Question: In a single sentence, describe what this figure presents.
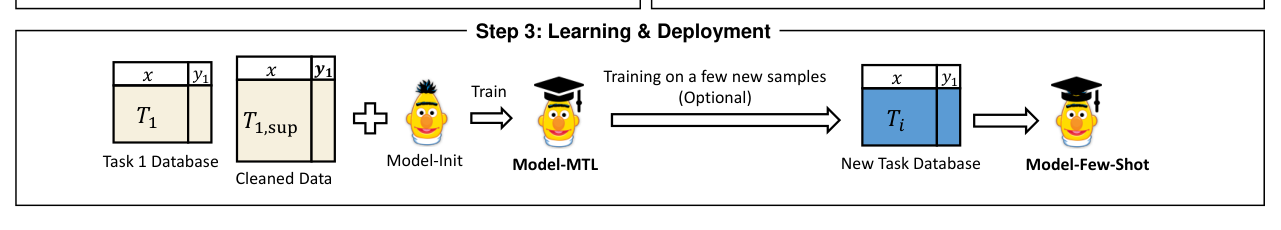
Answer: The demonstration of scaling medical tabular data predictors models (MediTab). It encompasses three steps: Step 1 consolidates tabular datasets using LLM; Step 2 aligns out-domain datasets with the target task; Step 3 facilitates the predictor with cleaned supplementary data. More details are presented in Section 2.2.